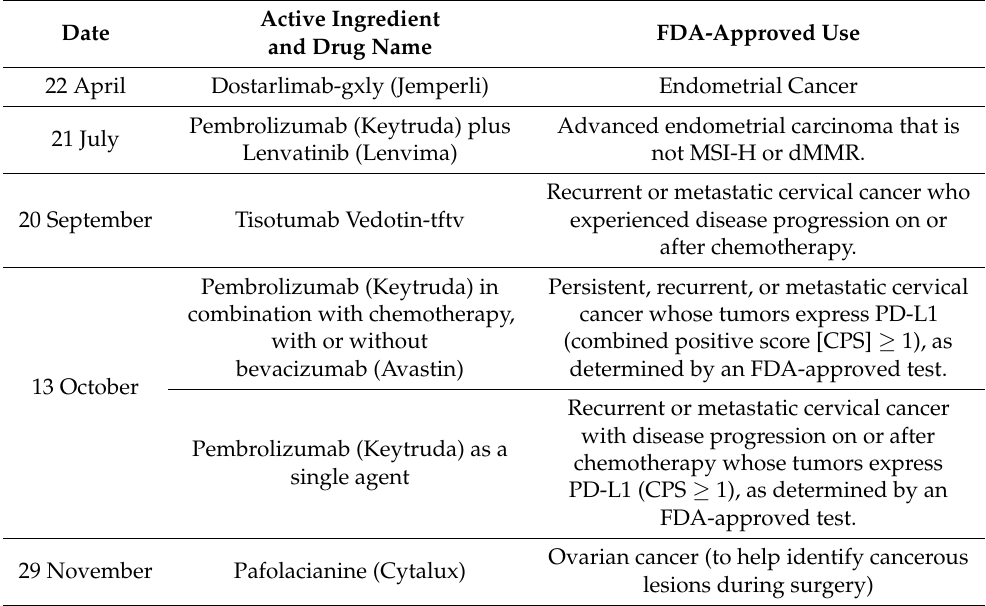
Table 1. FDA approvals in gynecological cancers in